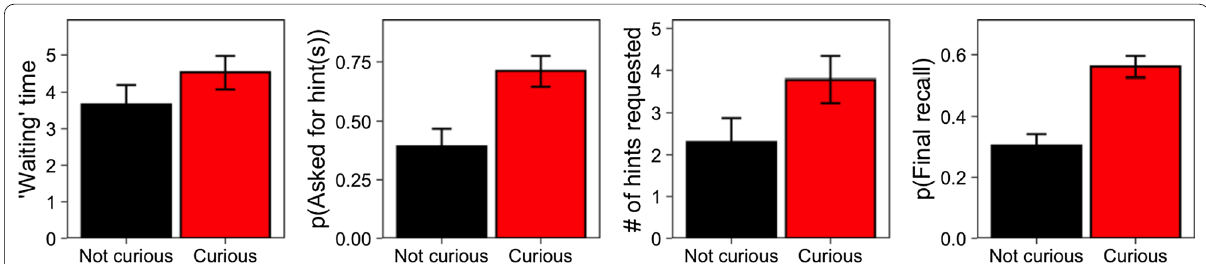
Fig. 3 Wait times, hint seeking, and final recall by curiosity, from Experiment 3. Note. Far Left: Time ‘waiting’ before requesting the answer as a function of curiosity. Left Center: Probability of asking for one or more hints as a function of curiosity. Right Center: Average number of letters (hints) viewed as a function of curiosity. Far Right: Probability of correct recall at posttest as a function of curiosity. Bars and error bars represent cross‑participant means with standard